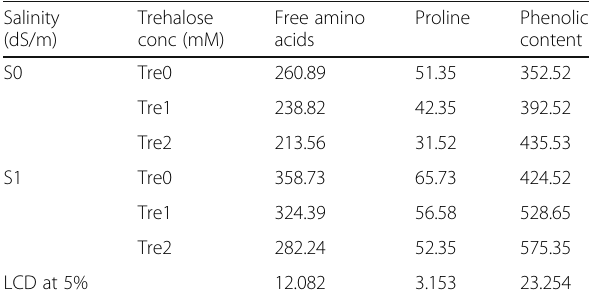
0.1 mM trehalose in improving phenolic contents. Table 6 Effect of trehalose at 0 mM (Tre 0), 10 mM (Tre 1), and 50 mM (Tre 2) on proline, free amino acids, and phenolic contents (mg/g DW) of wheat plants irrigated with tap water (S0) or diluted sea water at 6.25 dS/m (S1). Results are means